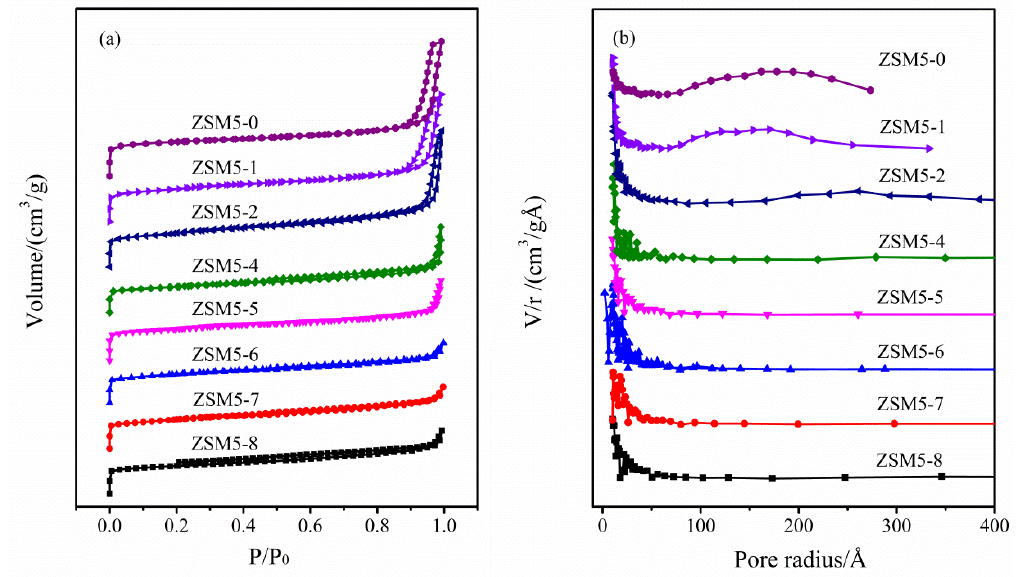
Figure 6. N 2 adsorption-desorption isotherms ( a ) and pore-size distributions ( b ) of ZSM-5 zeolite synthesized with different ethanol concentrations.